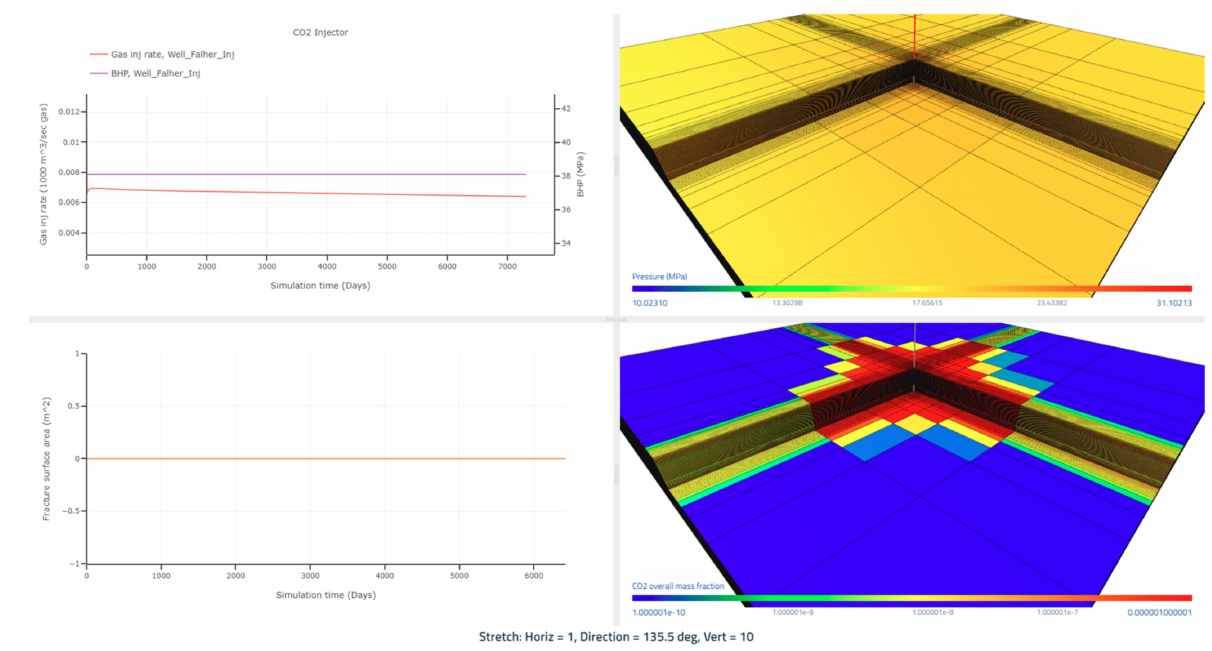
Figure 3. Example of the ResFrac™ model output for a CO 2 injector simulation in the Falher Formation. Upper right: pressure distribution in the model domain. Bottom right: CO 2 mass fraction distribution in the model domain. Upper left: CO 2 injection rate and bottomhole pressure. Lower left: fracture surface area created over injection